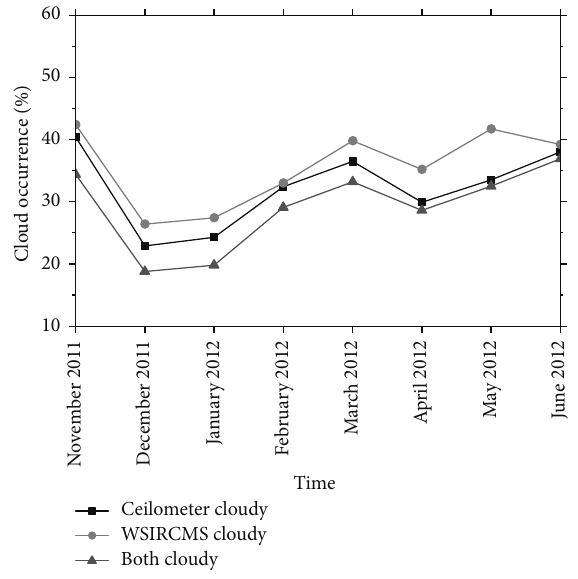
Figure 5: Monthly cloud occurrence for the period November 2011 to June 2012, as derived from ceilometer and